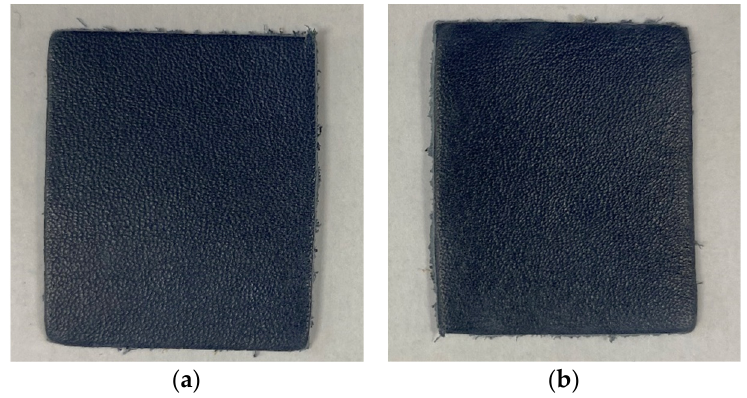
Figure 7. Pictures of ( a ) untreated and ( b ) plasma coated leather samples.